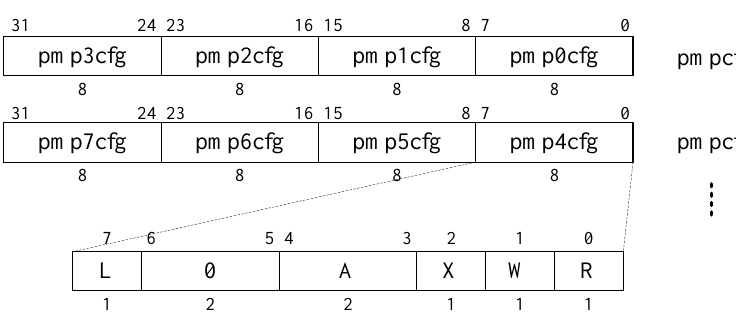
Figure 1: Format of pmpcfg [WA19]. Typically, pmp i cfg and pmpaddr i consist of a PMP